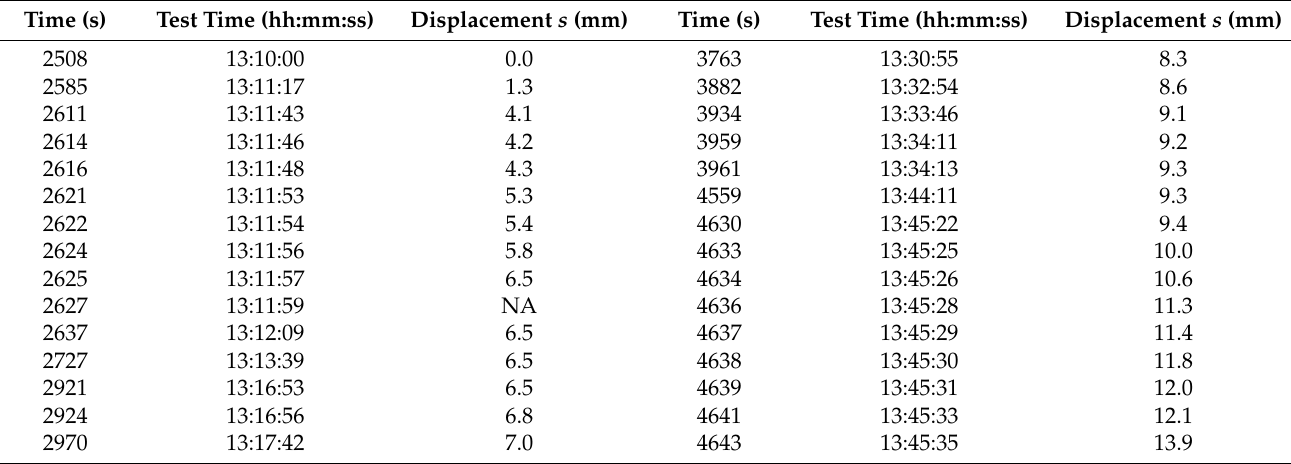
Table A2. Displacements of the cohesive central core tested in